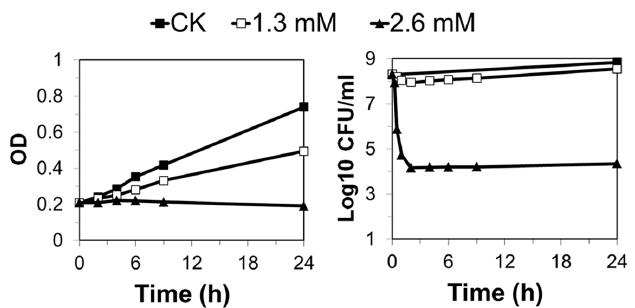
Figure 1. Exponential phase cultures were treated with 1.3 mM and 2.6 mM methanesulfonate (MMS), respectively. The cultures without any treatment were also grown at the same time as control (CK). The optical density (left panel) and cell viability (right panel) were analyzed during the treatment at indicated time points. The data are representative of three independent replicates. (CK, black squares; 1.3 mM, white squares; 2.6 mM, black triangles). OD, the optical density measured at a wavelength of 600 nm; CFU, colony formation unit.